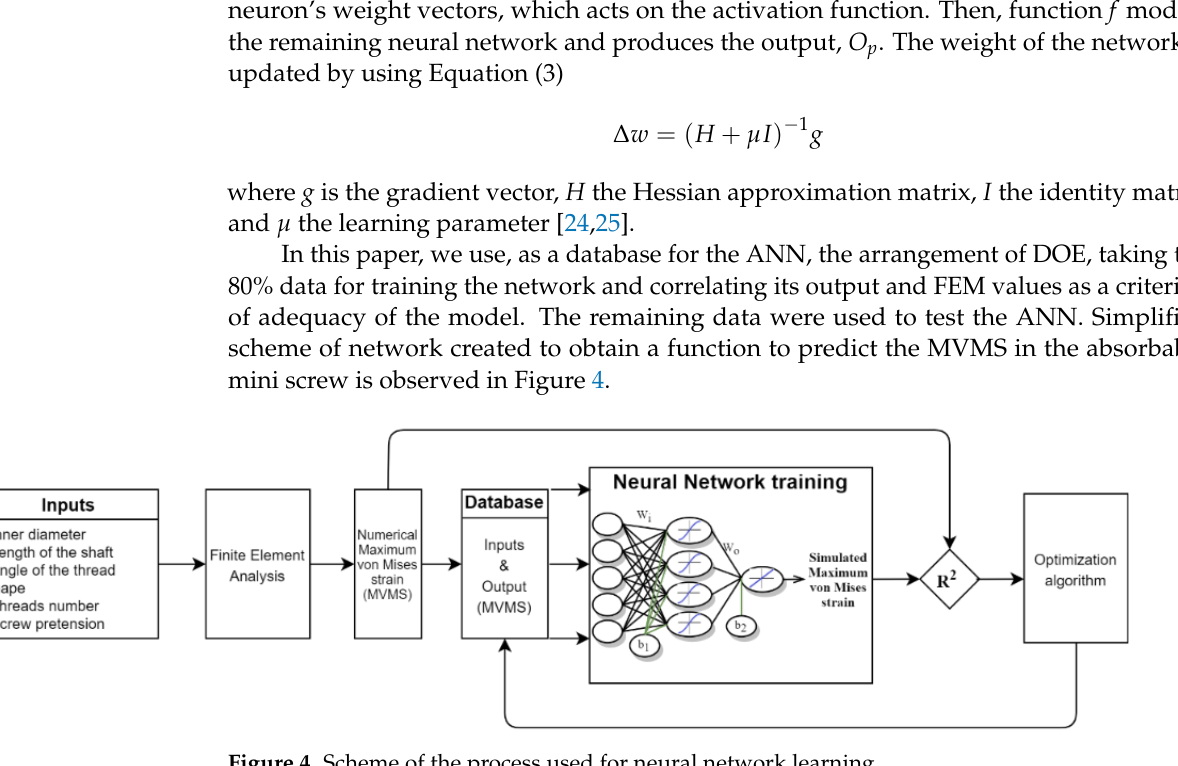
Figure 4. Scheme of the process used for neural network learning.